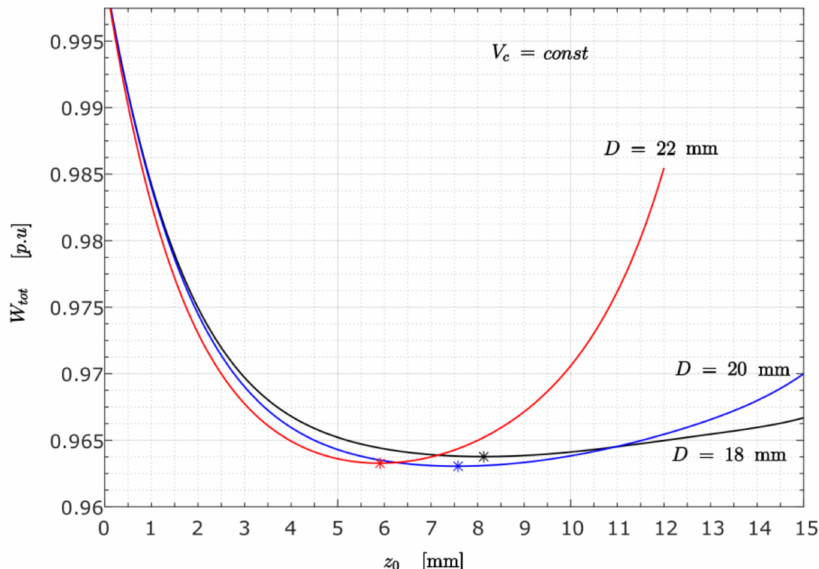
Figure 23. The PM’s equilibrium height calculated by EM. The results are shown for three different values of the container’s diameter, i.e., D = 18 mm, D = 20 mm, and D = 22 mm, respectively. The minimum value on the individual curve is indicated with the Asterisk (*). Each of the curves was normalized by its maximum value. In calculations the container’s volume V c remained